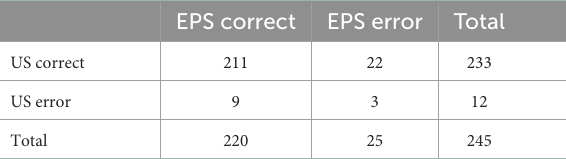
TABLE 5 Comparison of sensitivity and specificity between EPS and the inclusive combination of US and EPS. Inclusive combination (US or EPS)